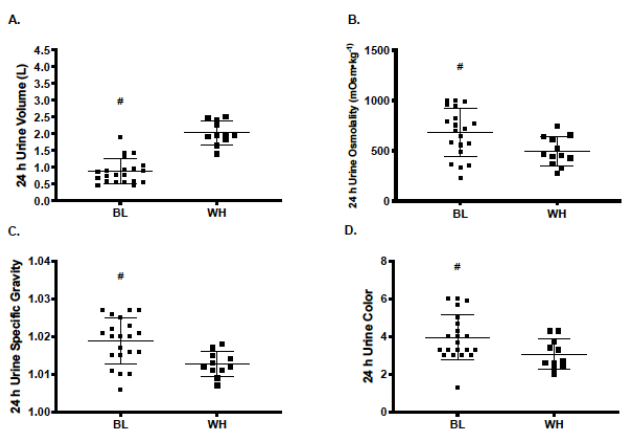
Figure 1. Differences in ( A ) 24-h urine volume, ( B ) 24-h urine osmolality, ( C ) urine specific gravity, and ( D ) urine color between non-Hispanic Black and non-Hispanic White college-aged males and females. # indicates statistical significance ( p < 0.01).